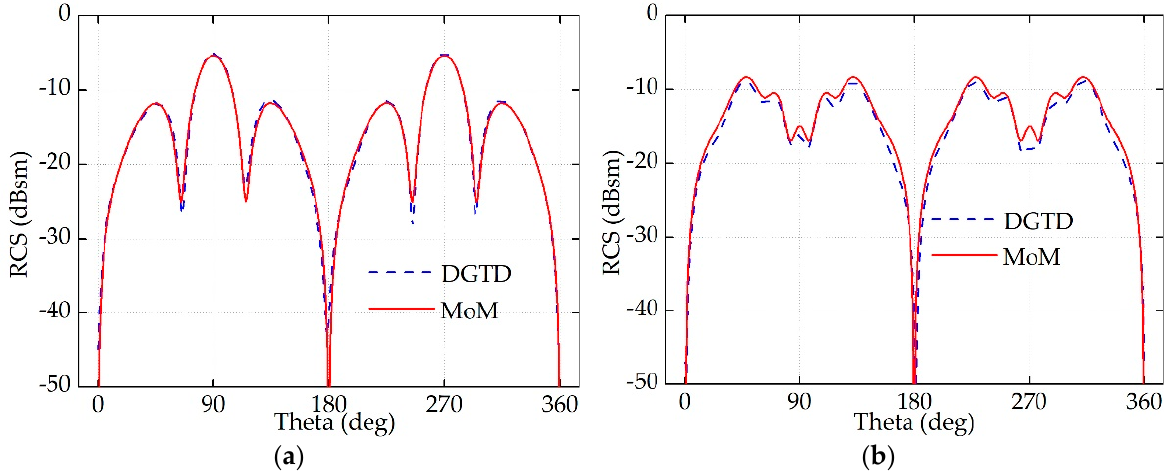
Figure 7. Multi-scale object-plate composite object.